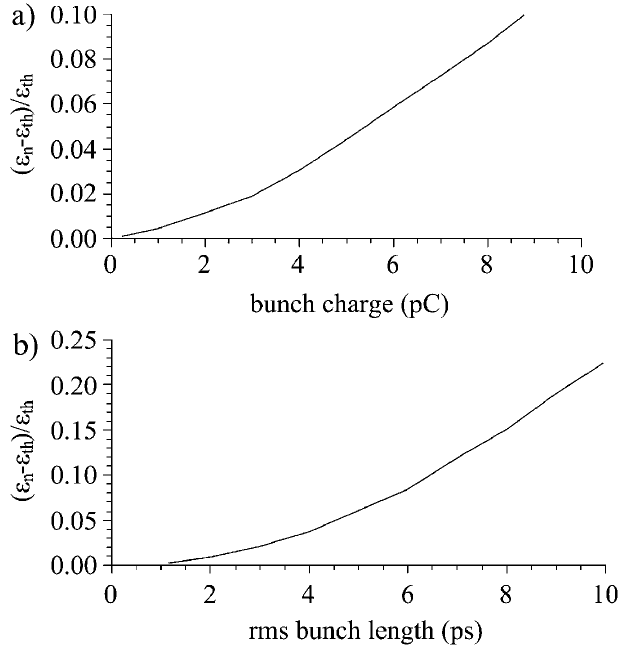
FIG. 15. ASTRA simulations for the influence of (a) space charge and (b) laser pulse length on the measured emittance " over the thermal emittance " for a maximum accelerating n th gradient of 60 MV = m (with rf phase adjusted for maximum mean momentum